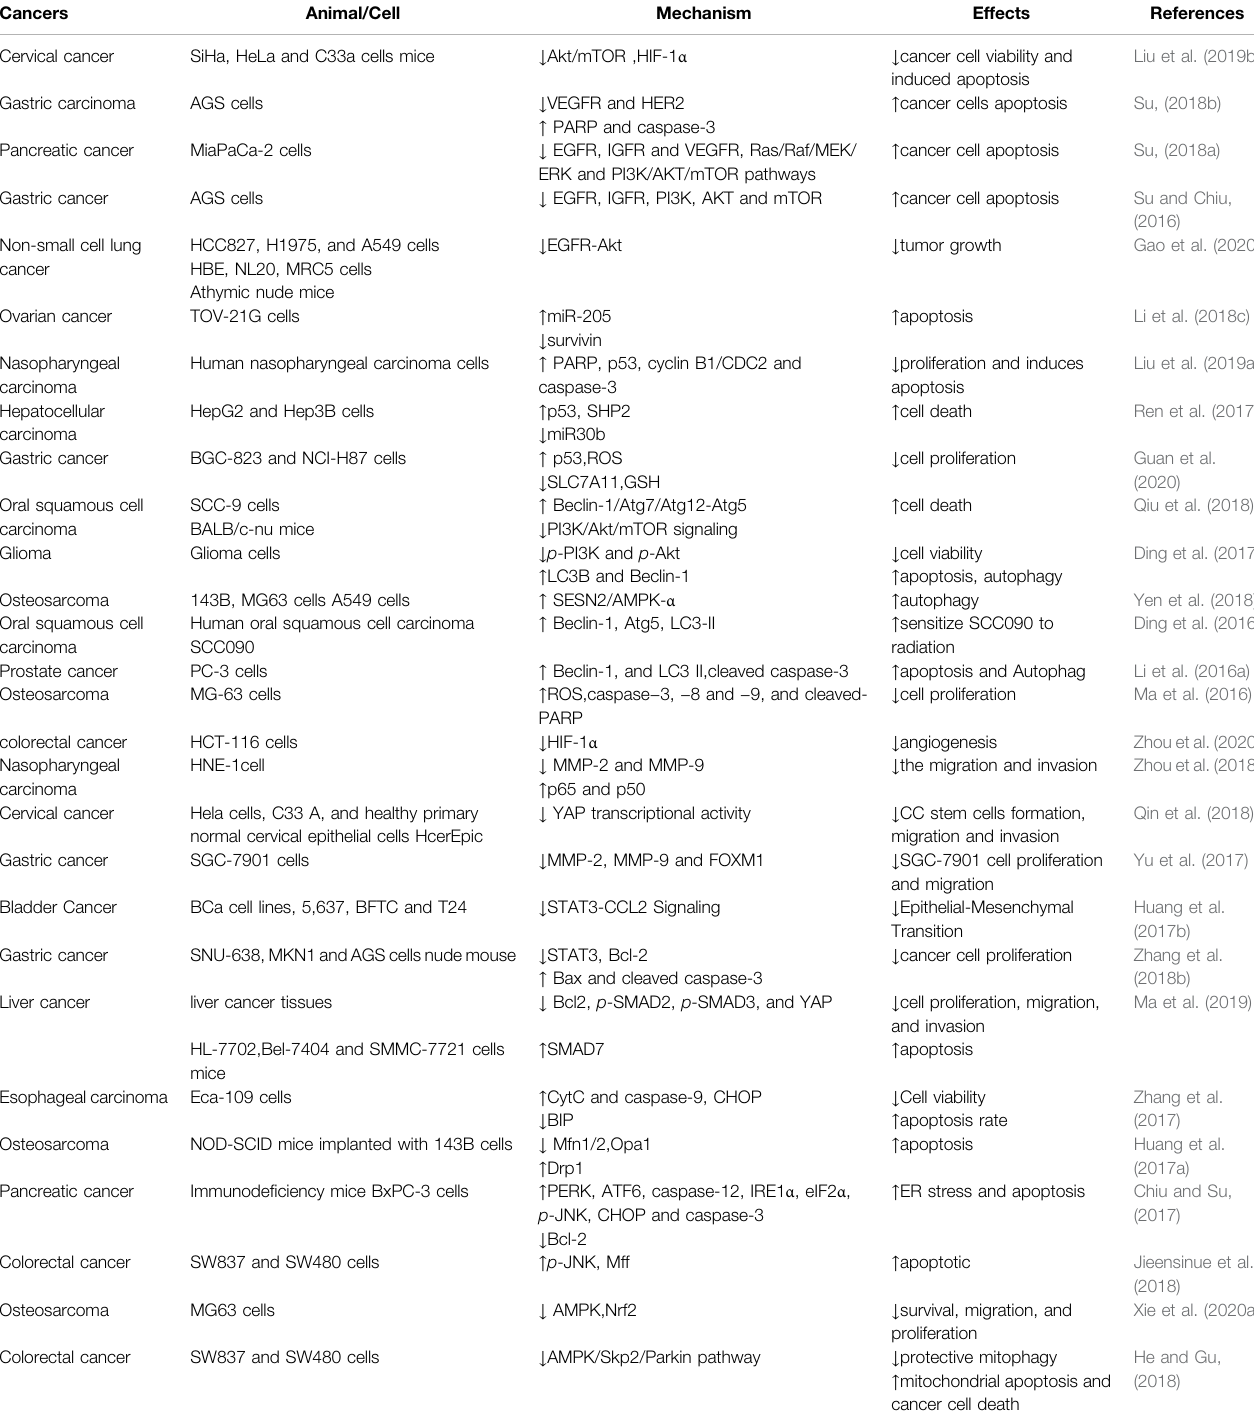
TABLE 1 | Summary of the anticancer effects and mechanisms of Tan